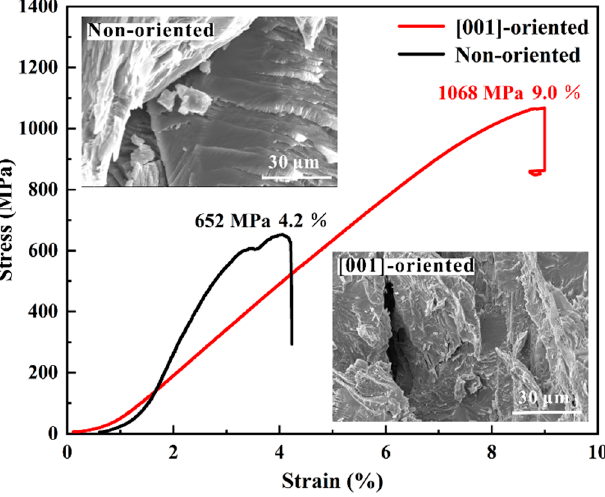
Figure 9. Compressive stress–strain curves at room temperature. Insets: SEM fractographs.